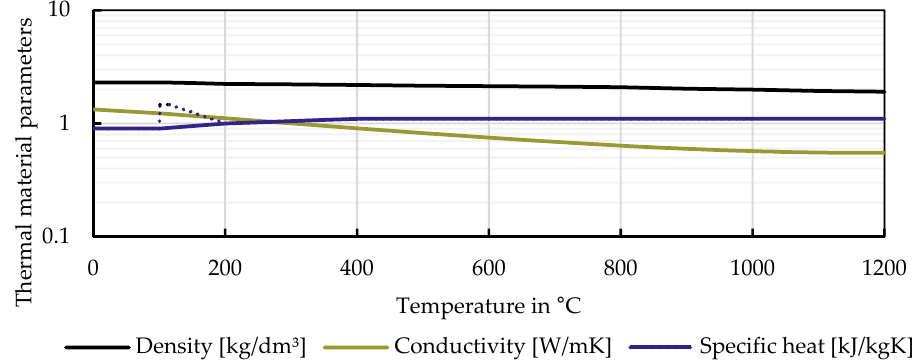
Figure 2. Calculated values of the temperature-dependent thermal material properties of concrete (reproduced from [8]).